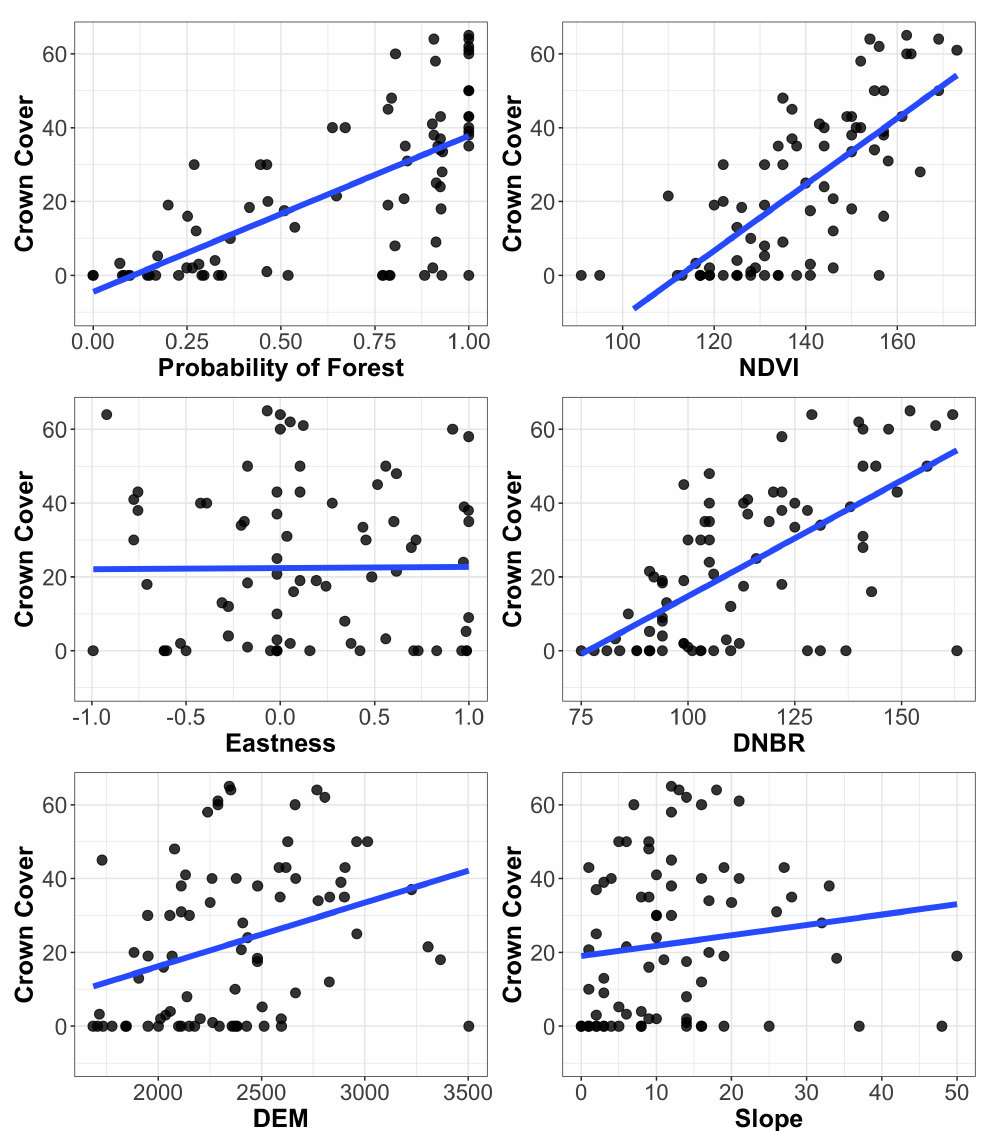
Figure 2. Crown cover graphed against the quantitative auxiliary variables. The least squares regression line is